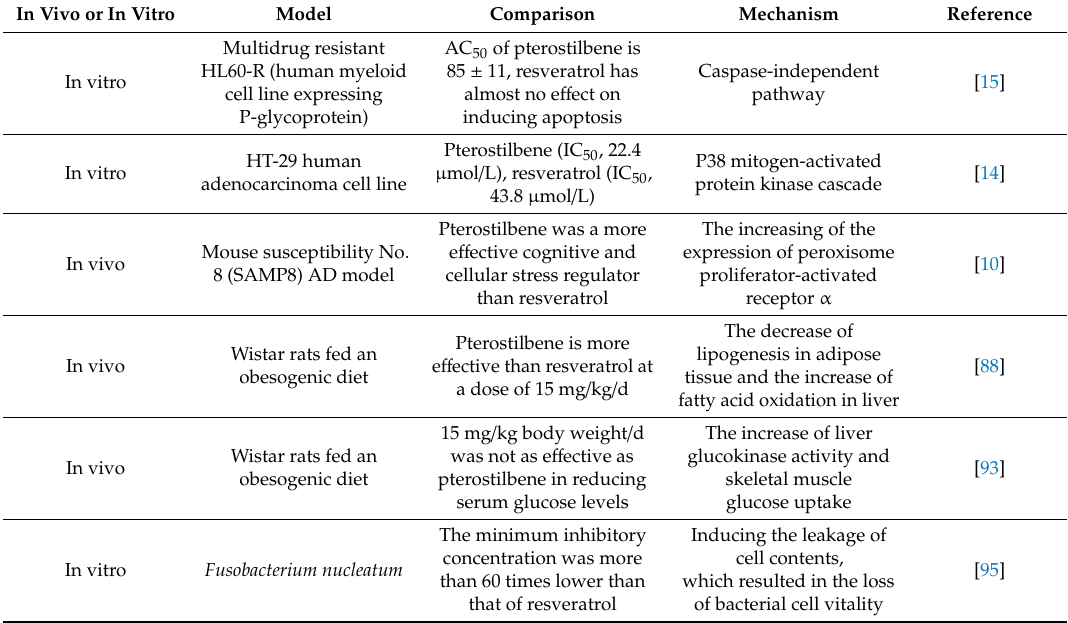
Table 7. Comparison between pterostilbene and